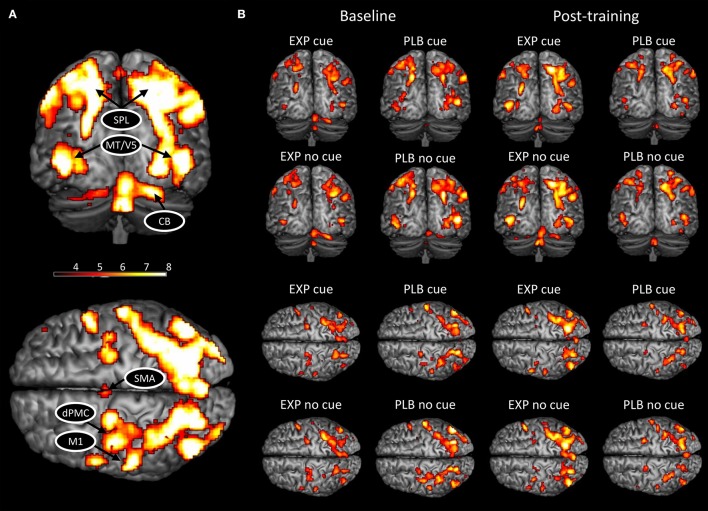
BOLD activation pattern during handwriting at baseline and post-training. (A) Activated network for both conditions combined; (B) Activated network in each condition and group separately at baseline and post-training. CB, cerebellum; HC, healthy controls; PD, Parkinson's disease; dPMC, dorsal premotor cortex; M1, primary motor cortex; SMA, supplementary motor area; SPL, superior parietal lobe; MT/V5, motion sensitive middle temporal visual area. The threshold was set at p < 0.001 (uncorrected) to achieve better visualization of all areas.